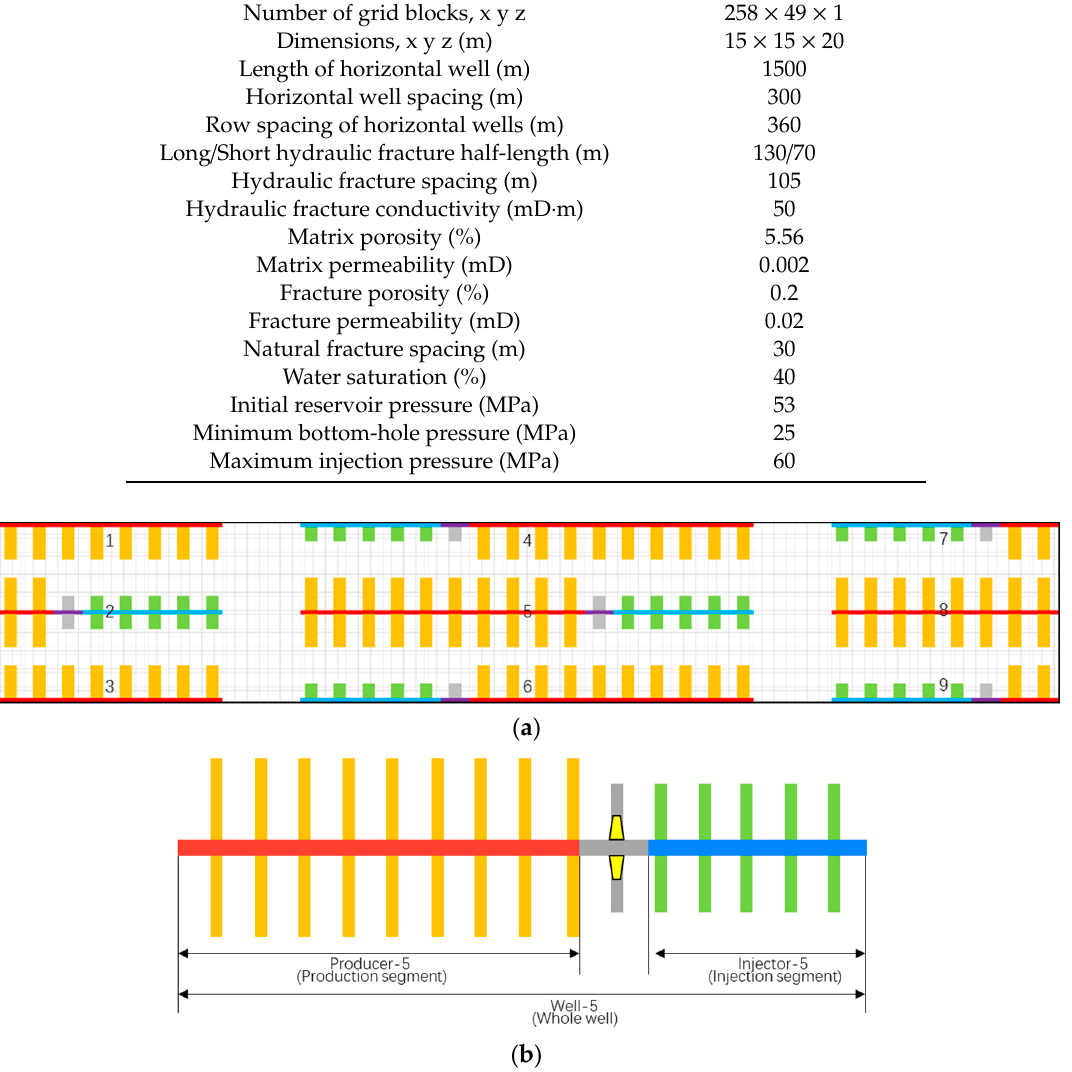
Figure 5. Diagram of simulation model. ( a ) Injection-production well pattern in the study area; ( b ) sketch for three horizontal wells in the same location in the model. Table 2. Data of seven pseudo-components.